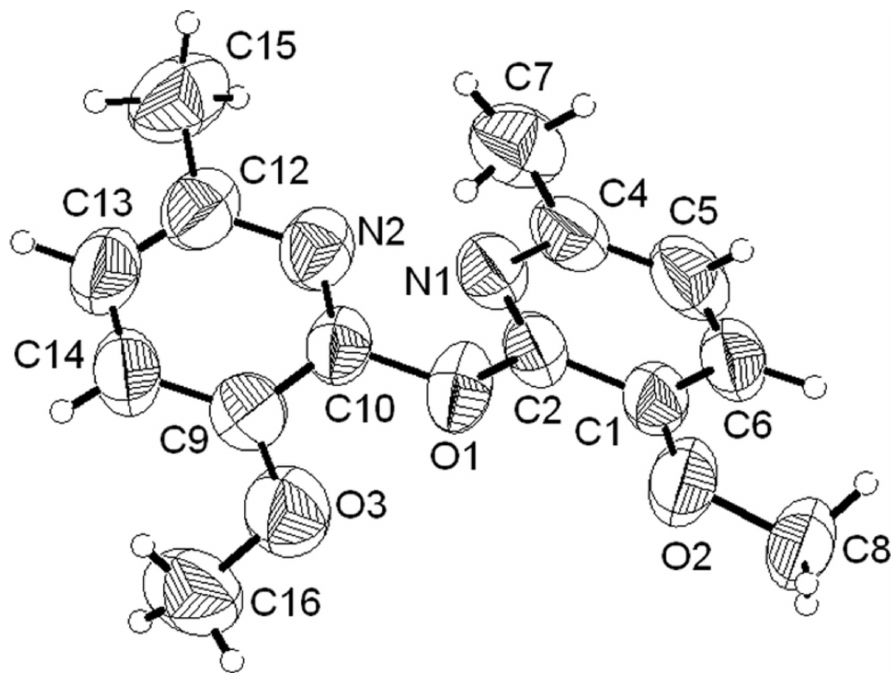
Figure 1 The molecular structure of the title molecule, with the atom-numbering scheme. Displacement ellipsoids are drawn at the 30% probability